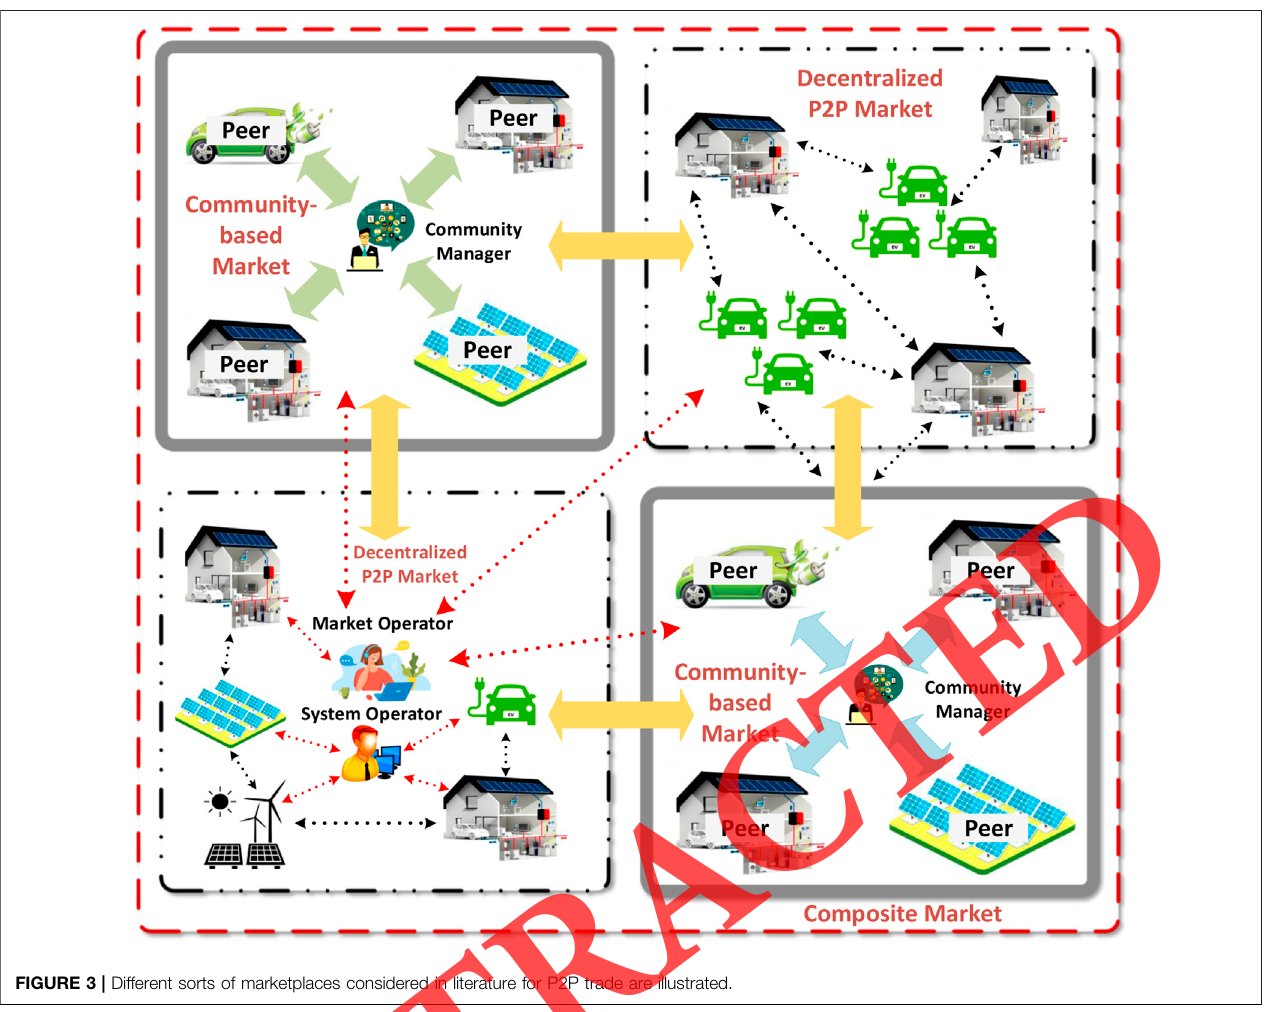
FIGURE 3 | Different sorts of marketplaces considered in literature for P2P trade are